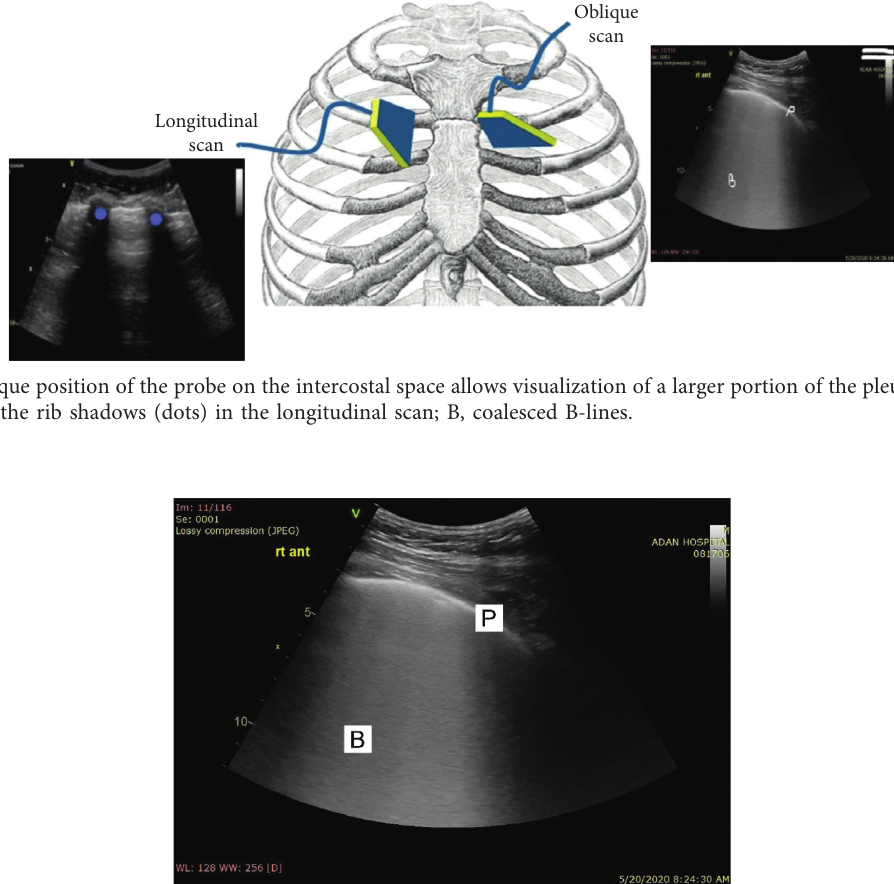
Figure 2: Coalescent B-lines giving the appearance of a shining white lung with irregular pleura. The B-lines maintain their brightness until the end of the screen. P, pleura; B, B-lines.